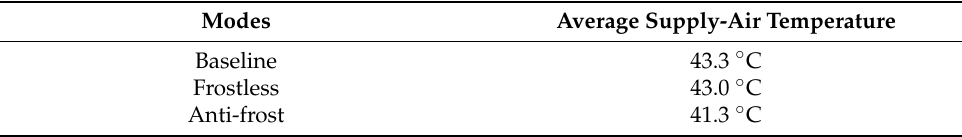
Table 3. Average values of supply-air temperature during frosting/defrosting cycles of the